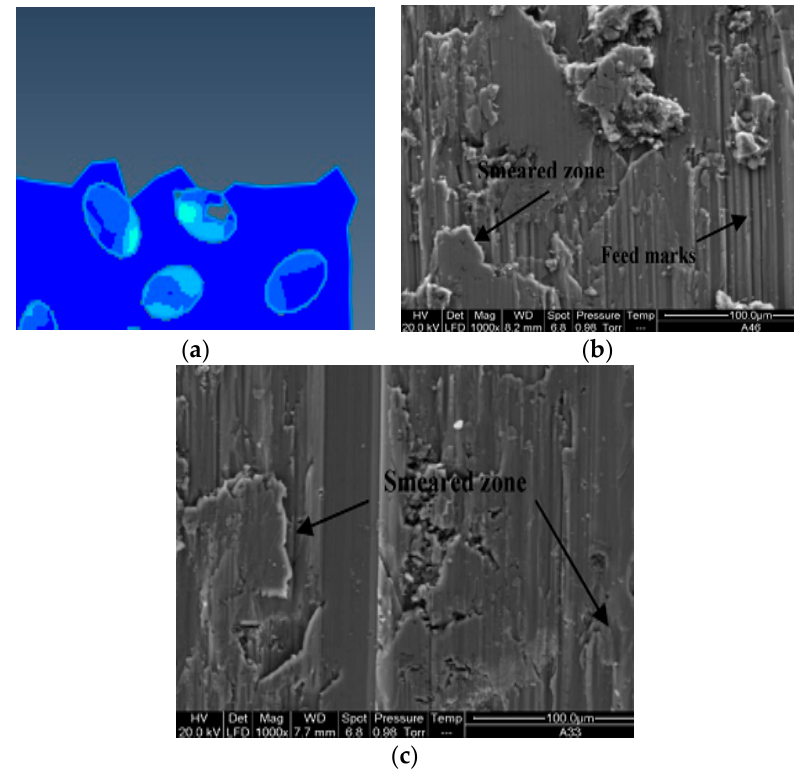
Figure 16. Micro cracks on the processed surface: ( a ) Simulation of surface topography cut through and feed marks, ( b ) cut through actual surface topography, ( c ) feed marks actual surface topography. ( b , c ) Adapted with permission from ref. [36] Copyright 2007, Elsevier.